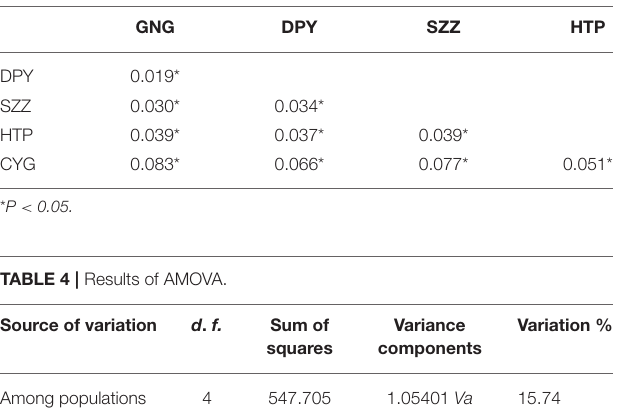
TABLE 3 | Pairwise F ST (lower triangular) and permutation test.